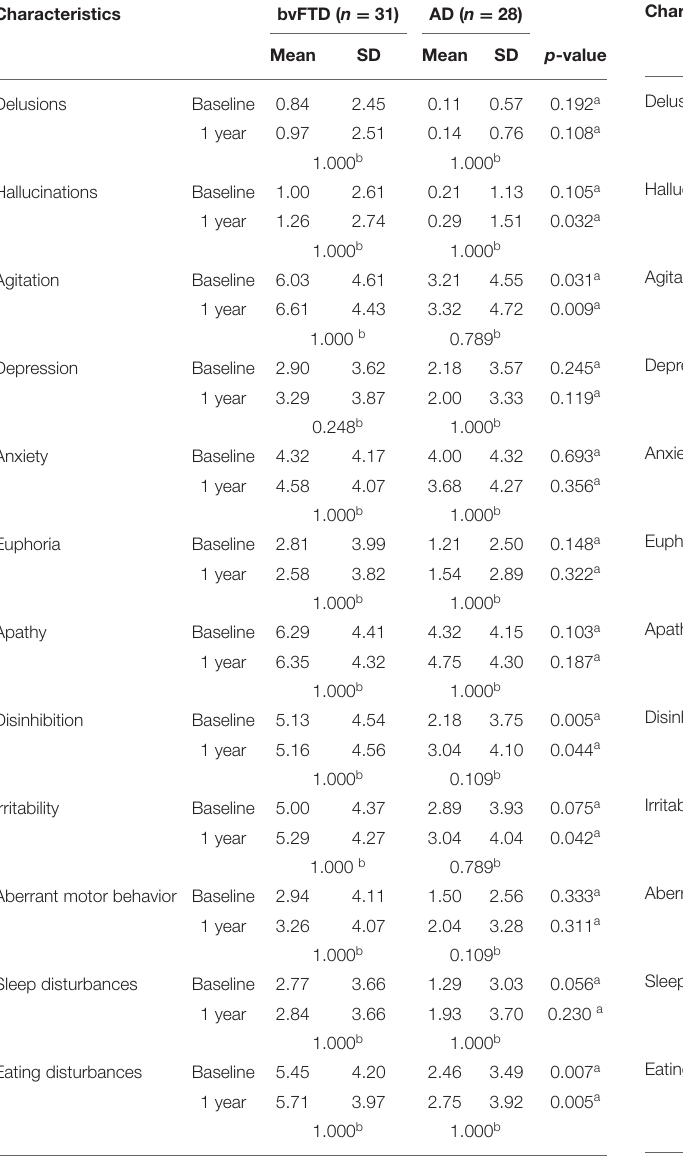
TABLE 3 | Mean neuropsychiatric inventory distress reported by caregivers for each domain.